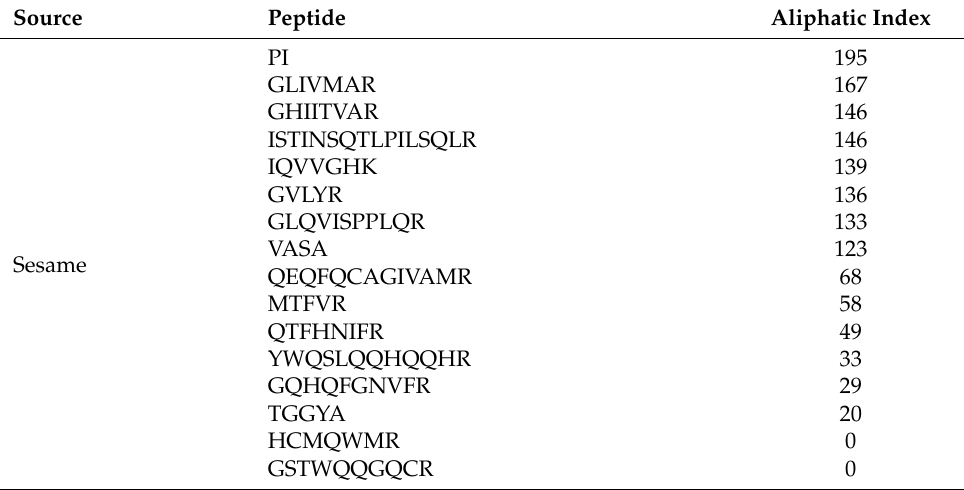
Table 3. Aliphatic indices of 49 oilseed-derived peptides predicted to be non-toxic and having low water solubility, in comparison with reference peptide lantibiotic